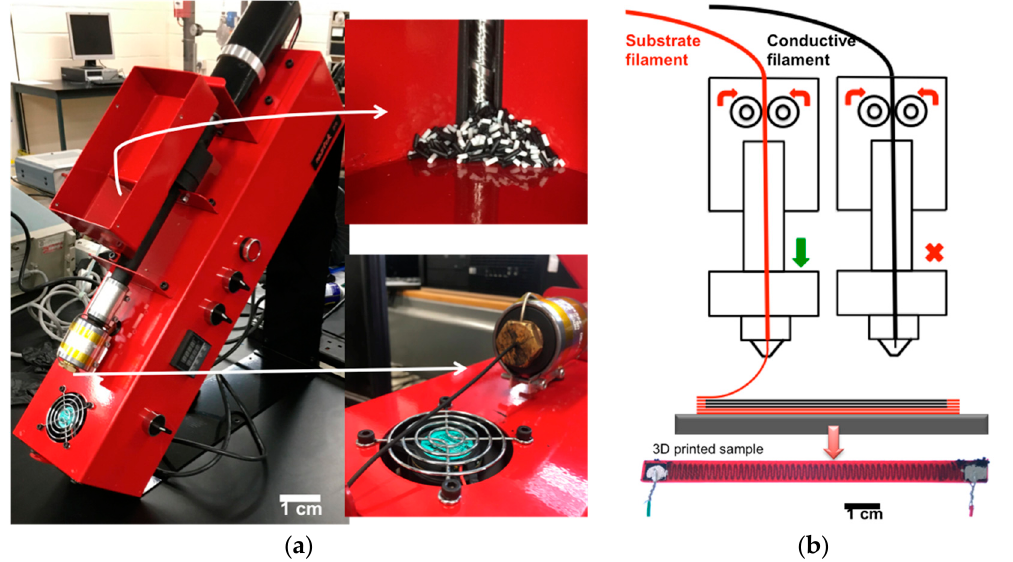
Figure 1. ( a ) Preparation of the sensing material via single-screw extruder (inset of mixed pellets and the extruded 1.75 mm strand); ( b ) The schematic process of 3D FDM dual printing.